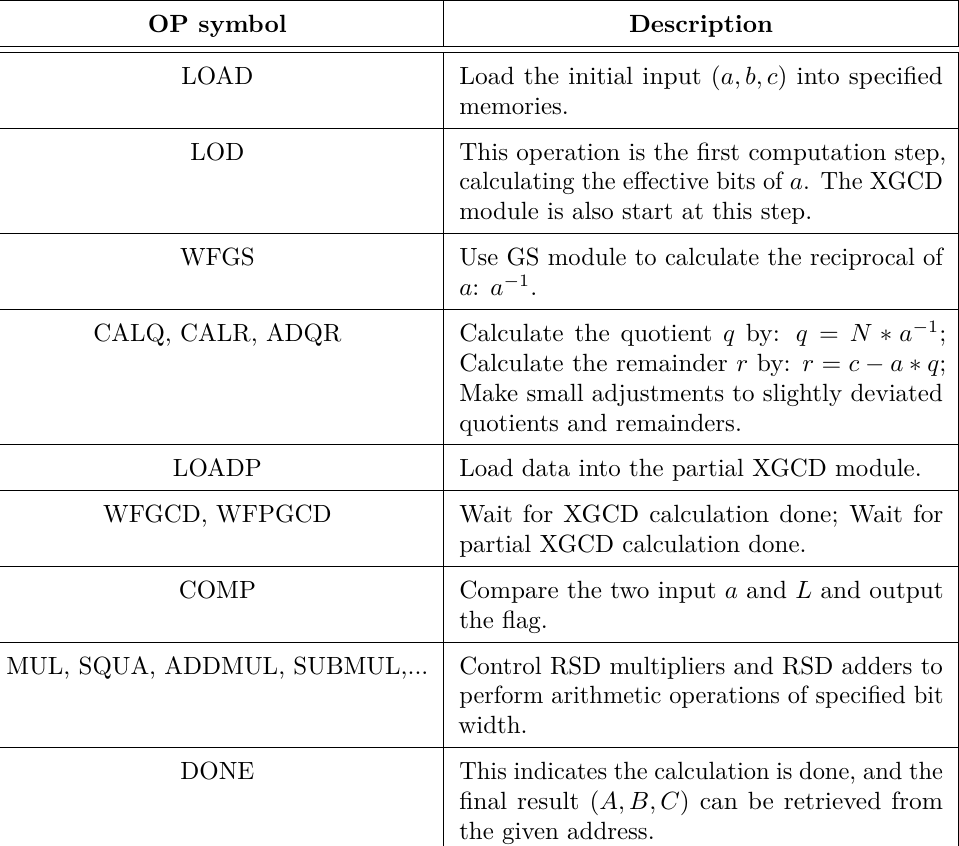
Table 4: The typical OP symbols and their operation